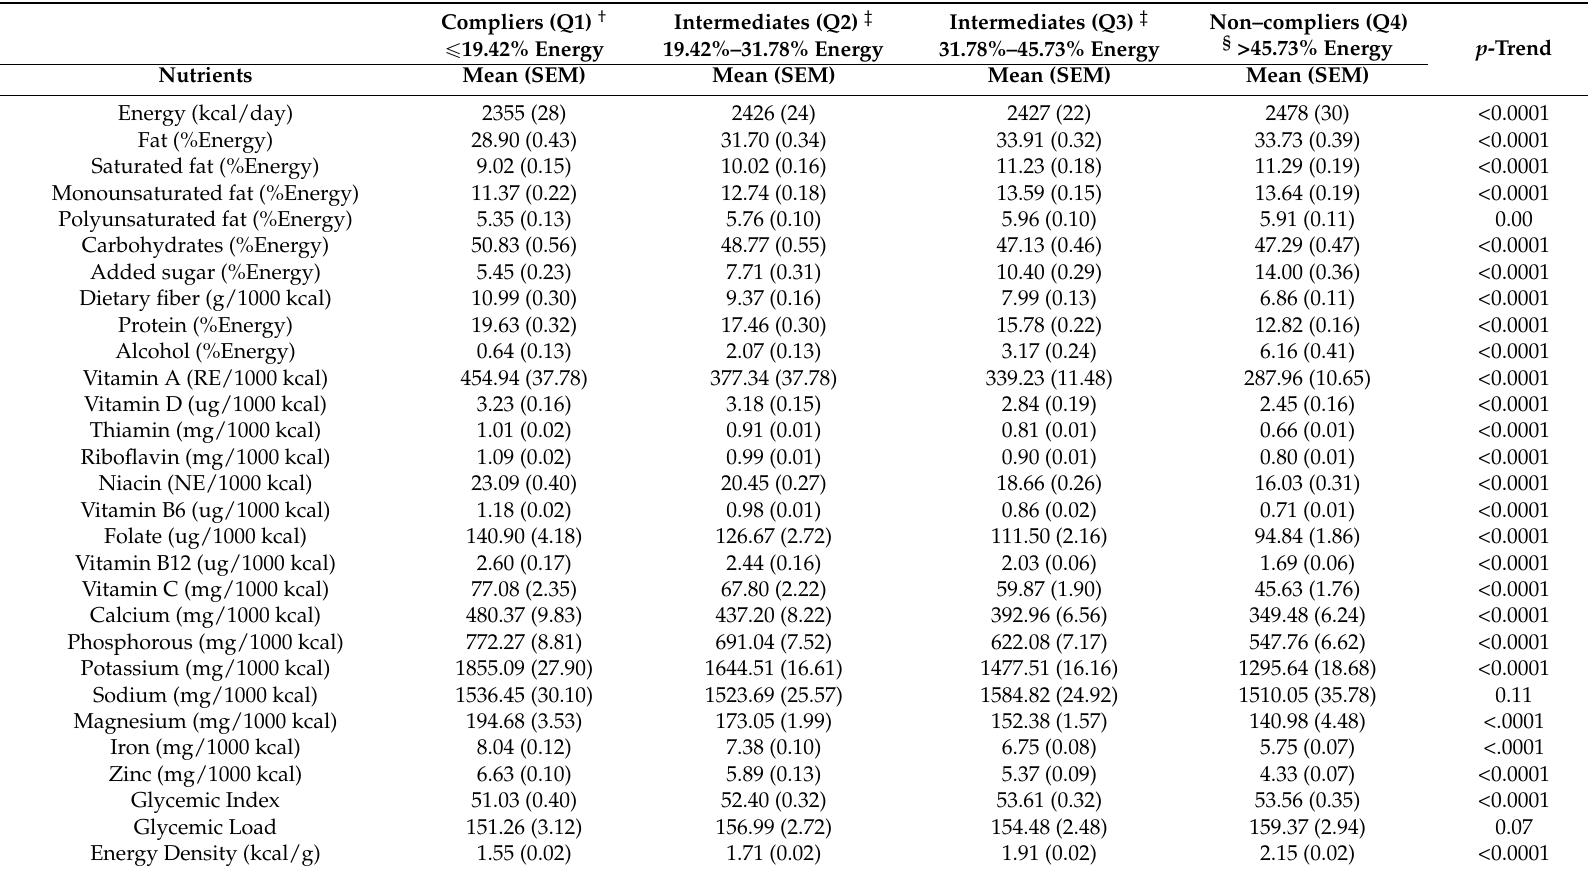
Table 4. Weighted analysis of nutrient intakes (density approach) [25] by compliers, intermediates, and non-compliers based on the percentage of energy consumed from Tier 4 foods and “other” foods/beverages among Canadian adults ( ě 19 years), adjusted for age, sex, and misreporting status (under-reporter, plausible-, and over-reporters)